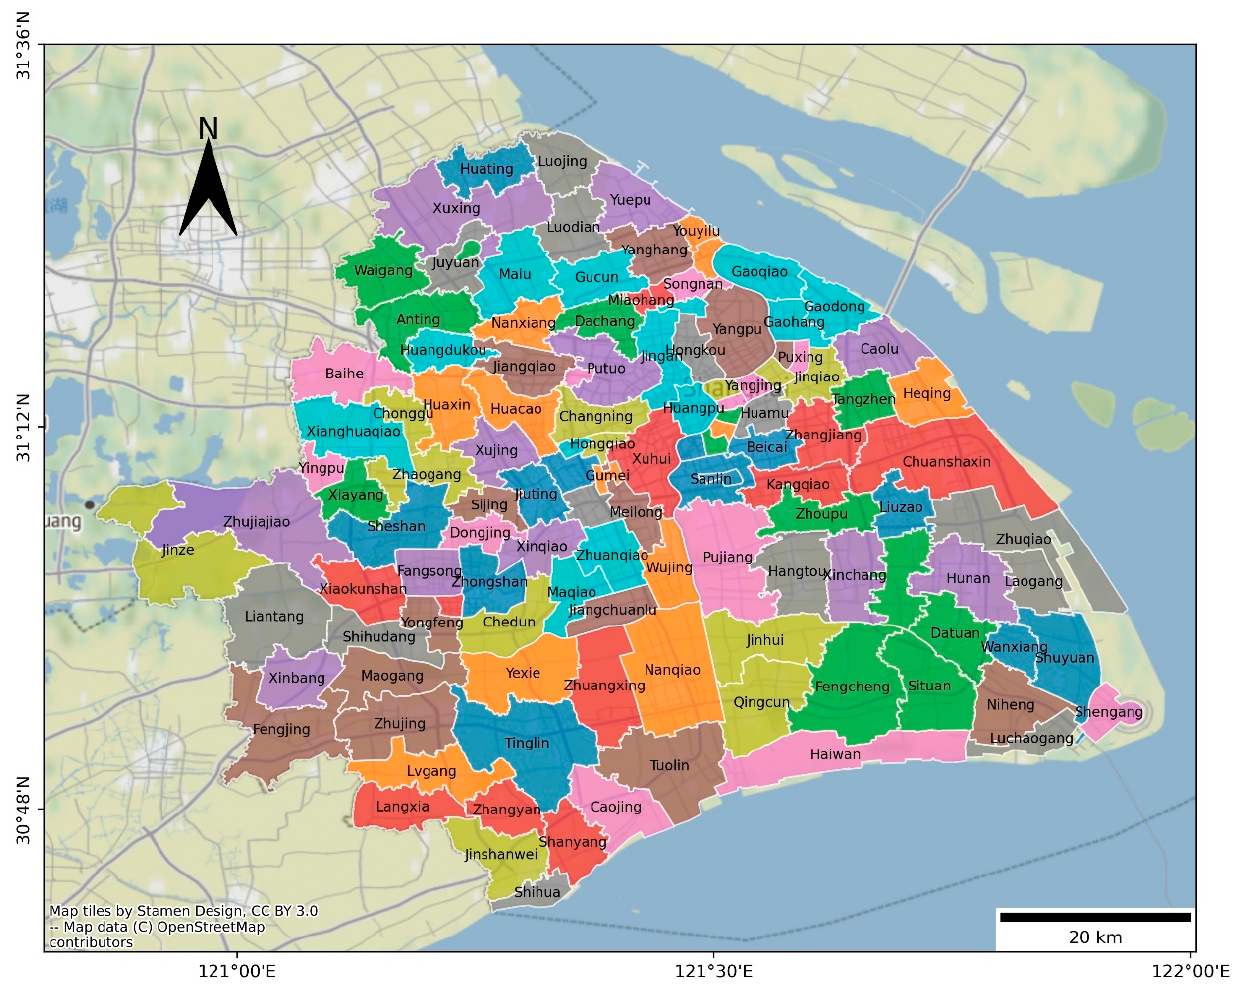
Figure 1. Distribution of the sample study area in Shanghai. Table 1. Summarization of the factors influencing the urban carrying